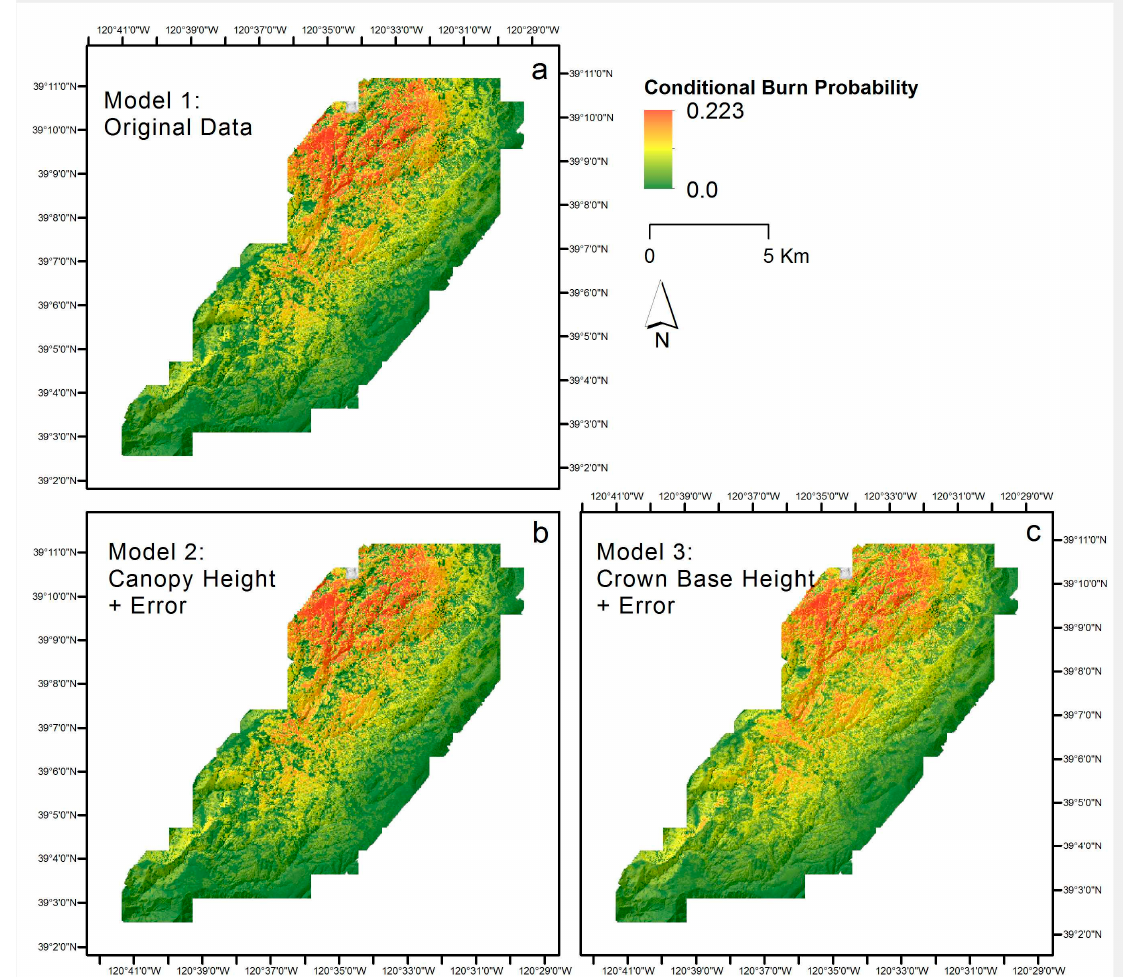
Figure 3. Map of conditional burn probability (CBP) for high severity fires across the Last Chance study area (40 m resolution): ( a ) Model 1 (original data); ( b ) Average CBP for 100 runs of Model 2 (CH + Error); and, ( c ) Average CBP for 100 runs of Model 3 (CBH + Error). The difference between Model 1 and Model 2 was slight, and ranged from − 0.055 to 0.007. CPB increases were apparent on the margins of the study area, and largest decreases in the central study area, areas with higher CC and elevation. The difference between Model 1 and Model 3 was larger, and ranged from − 0.122 to 0.116 (Figure 4). Increases in CBP were apparent across the study area and decreases were apparent mainly in the northwest.